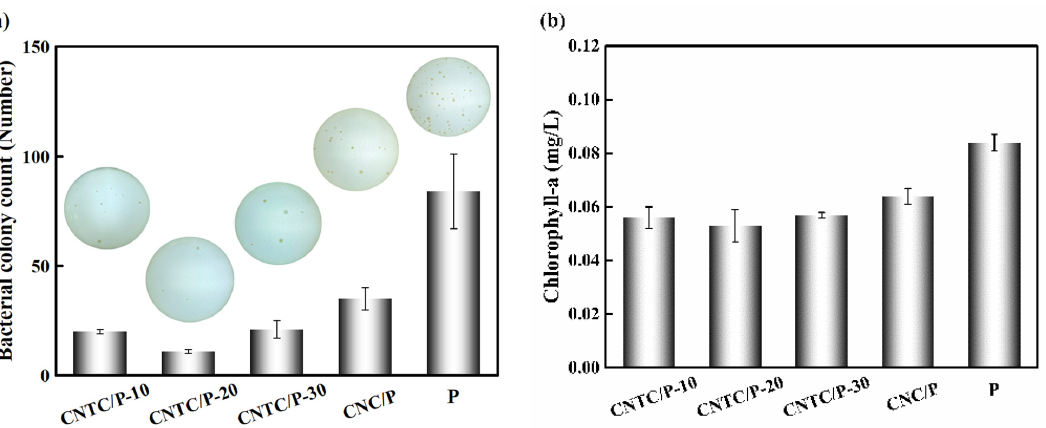
Figure 7. ( a ) Bacterial colony attached on studied coatings; ( b ) Chlorophyll-a concentration of the diatom attached on studied